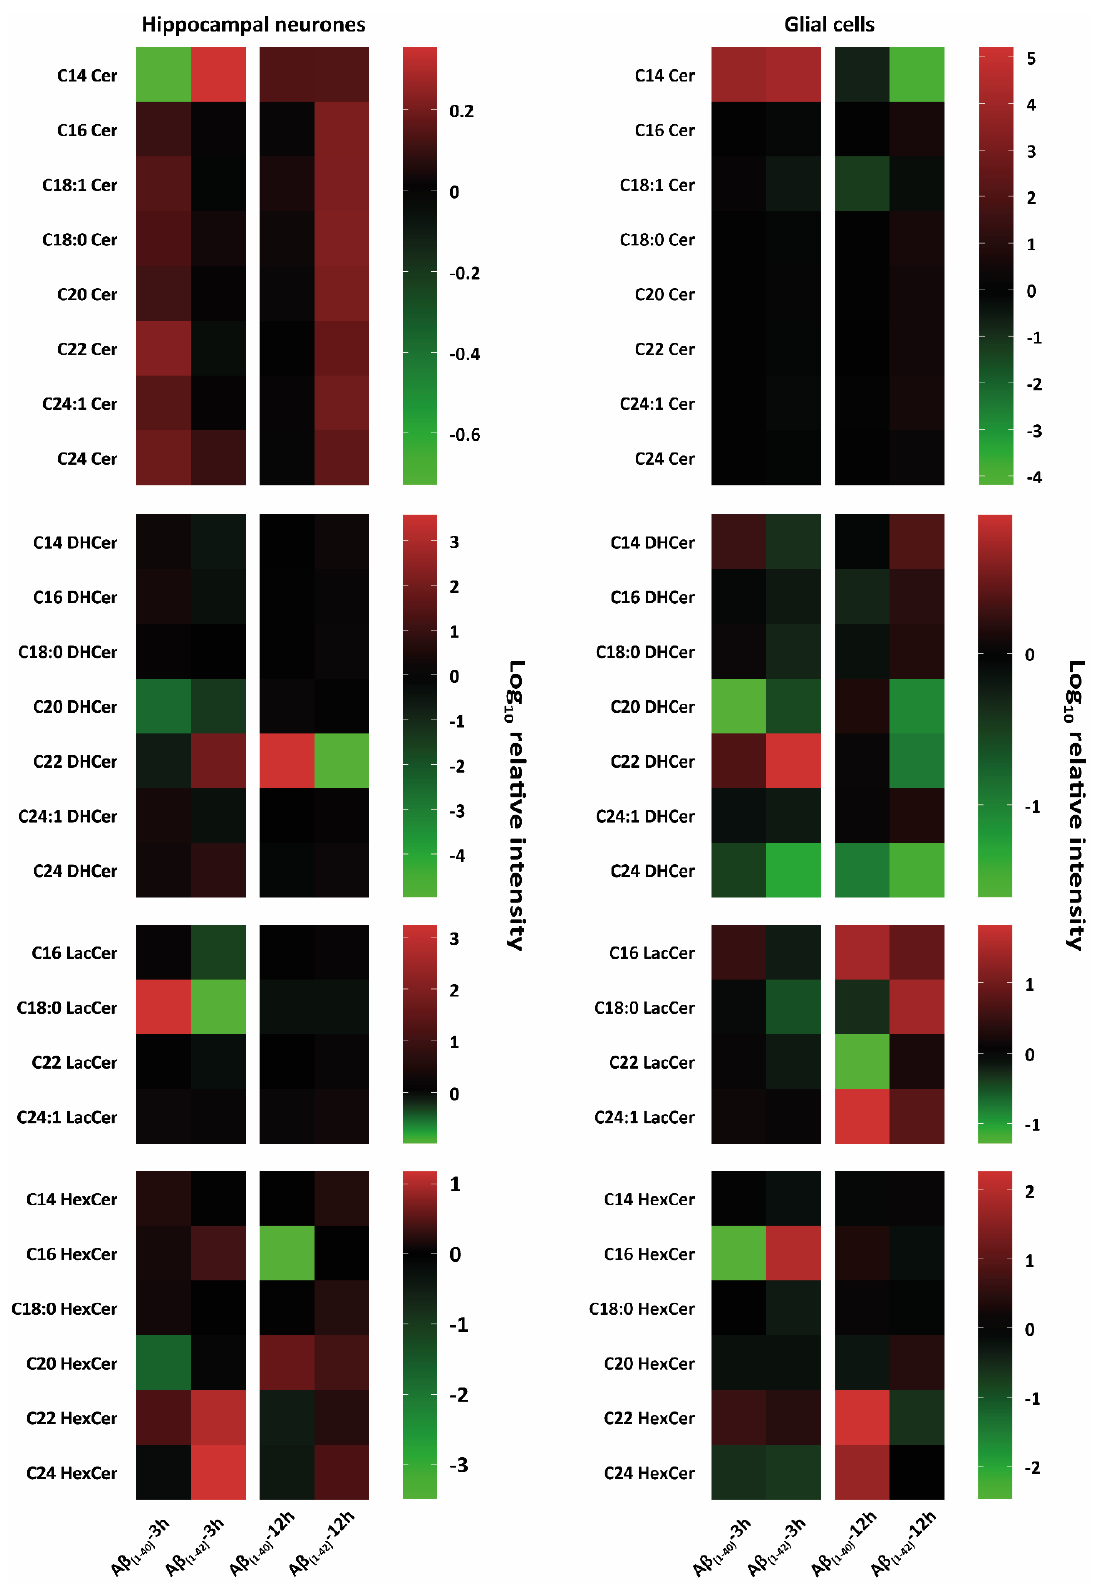
Figure 2. Heat-map-based mass spectrometry analysis of sphingolipid classes from hippocampal neurones and glial cells after 3 h and 12 h A β treatment. Here, we examined different